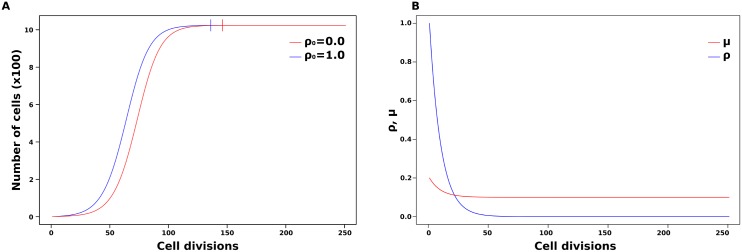
Effect of the parental repressor on cell division speed.(A) Comparison of a cell division dynamics model with the effect of parental repressor (ρ0 = 1.0) and without (ρ0 = 0). (B) Change in amount of parental repressor ρ and speed of cell division μ throughout development, with ρdeg = 0.1. Vertical bars mark cell divisions at which the equilibrium is achieved.